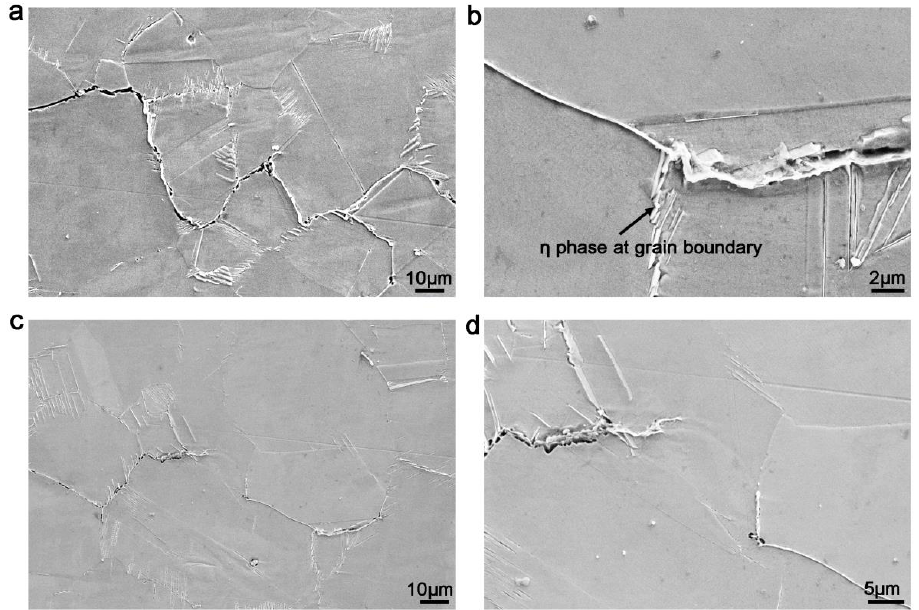
Figure 6. Crack propagation paths in 718Plus alloy with 5 s hold-time. ( a ) Propagation path; ( b ) precipitation at grain boundaries; ( c ) morphology at crack tip; ( d ) oxide strip at crack tip.